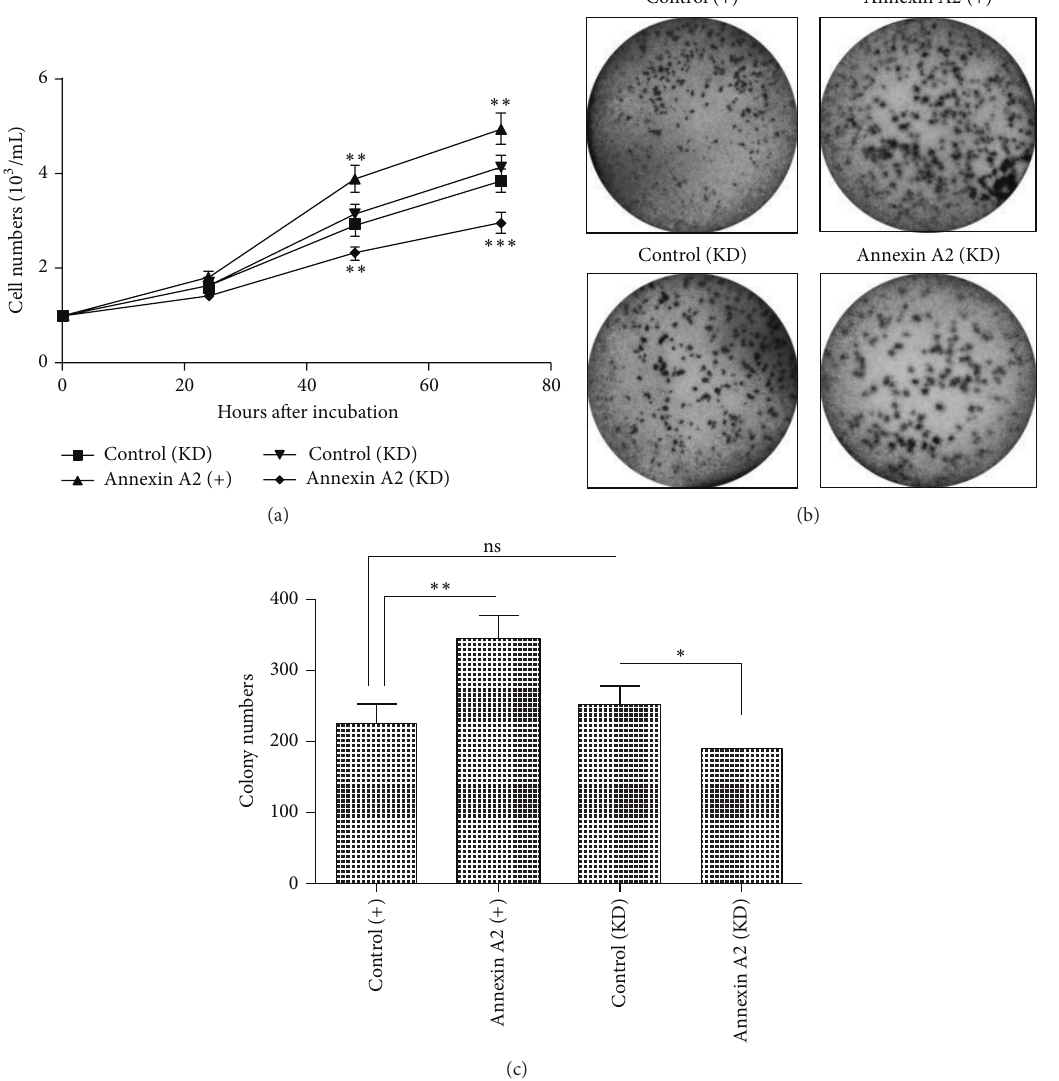
Figure 3: Positive regulation of Annexin A2 in the proliferation of Caco-2 cells. (a) Growth curve of Annexin A2 overexpressed (Annexin A2 (+)), Annexin A2-knocked down (Annexin A2 (KD)), and the two groups of control Caco-2 cells (control (+) and control (KD)), and the cell number was quantified in each group after an incubation of 24, 48, or 72 hours; (b) colony forming assay of the four groups (Annexin A2 (+), control (+), Annexin A2 (KD), and control (KD)) of Caco-2 cells after 48-hour incubation; (c) colony counting of the four groups of Caco-2 cells after 48-hour incubation. Results were repeated in triplicate independently, ∗ represented 𝑝 < 0.05 , ∗∗ represented 𝑝 < 0.01 , and ∗ ∗ ∗ represented 𝑝 < 0.001